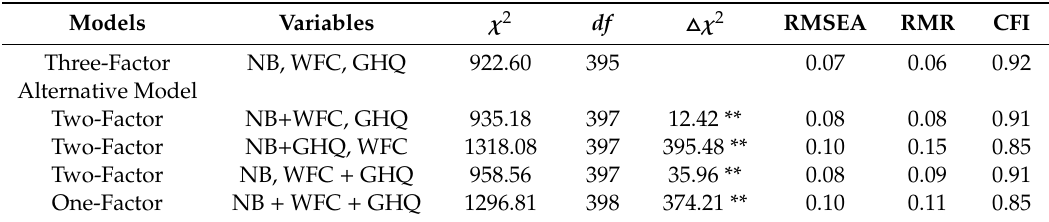
Table 1. Confirmatory Factor Analysis.